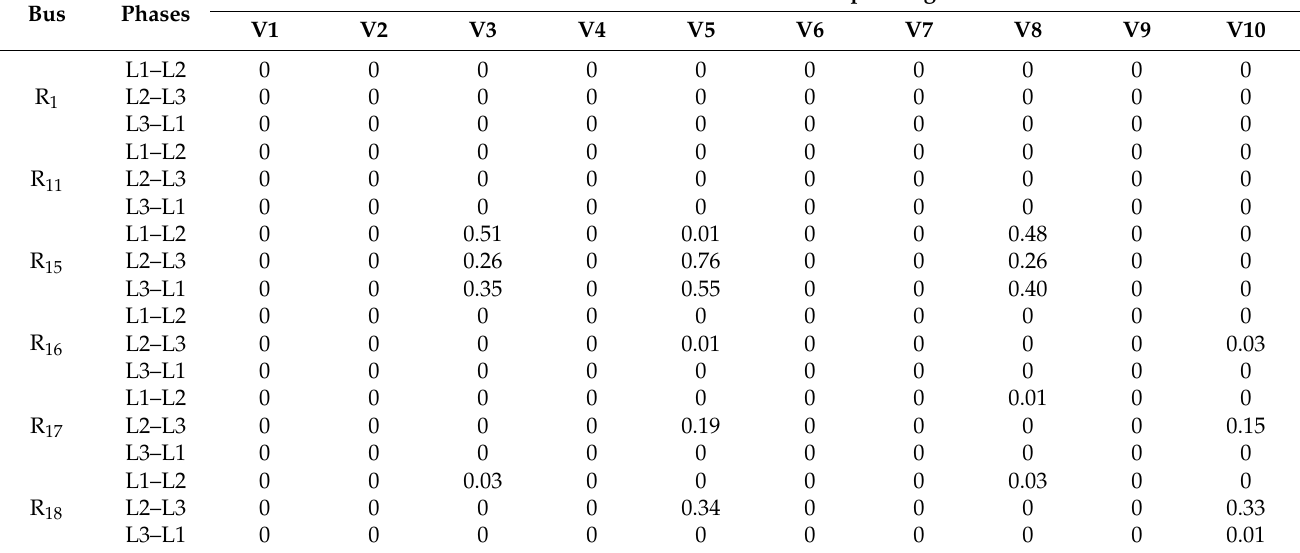
Table 5. The risk of exceeding the upper limit of the bus voltage R S test network.